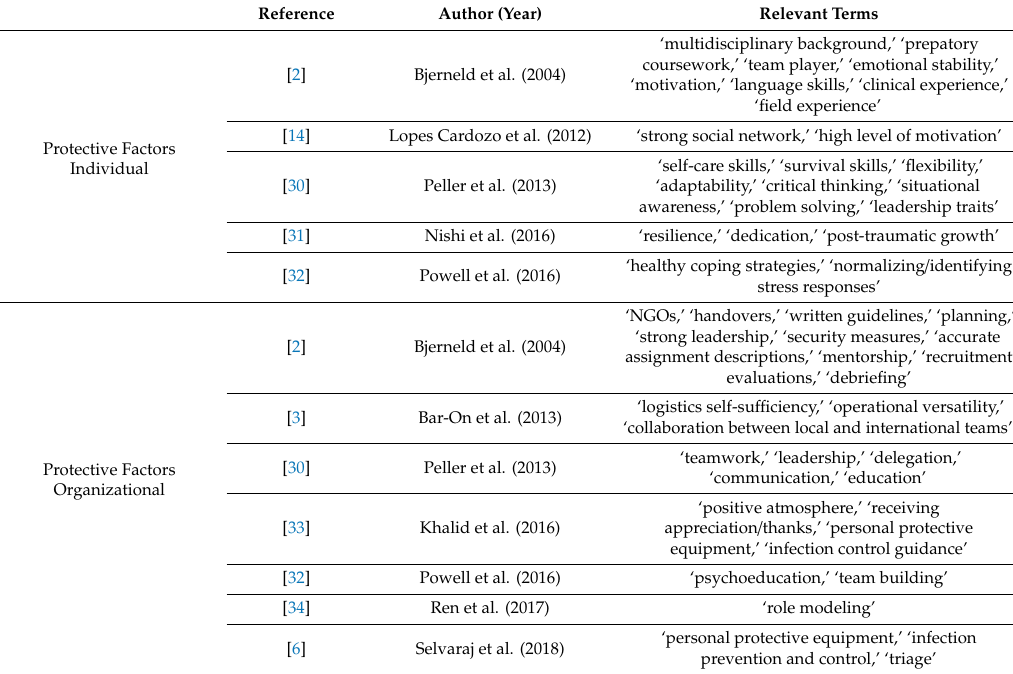
Table 3. Crisis health worker’s protective